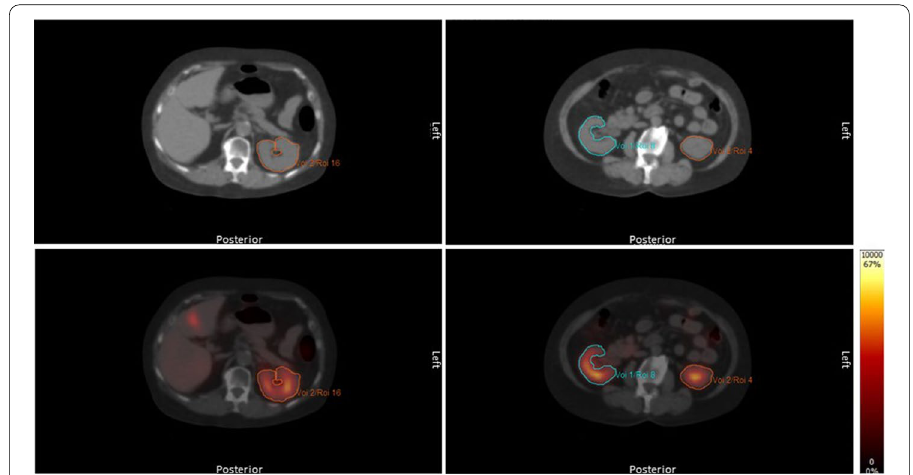
Fig. 2 Delineation of kidneys on two transverse slices of a CT scan (top row) and copy to fused images (bottom row) with activity concentration given by the colored scale in units of 100 Bq/cm